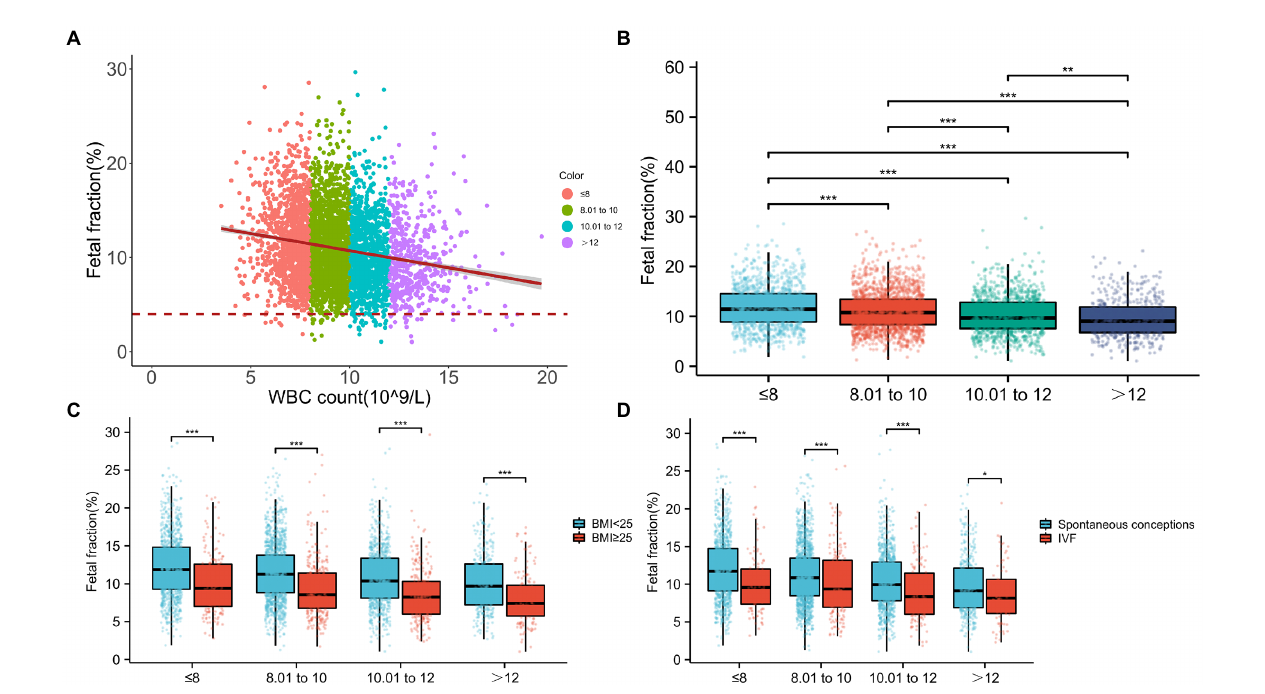
FIGURE 3 Relationship between fetal fraction (FF) and white blood cell (WBC) count. (A) Scatterplots of FF according to WBC count categories. (B) The median FFs across WBC count categories are 11.45, 10.77, 9.67, and 9.02, respectively. (C) In the same WBC count categories, FF decreases with a higher BMI. Similarly, in the same BMI categories, FF decreases with WBC count. (D) In the same WBC count categories, FFs are significantly higher in spontaneous conceptions than in IVF conceptions. Similarly, in the same mode of pregnancy, FF decreases with the WBC count.